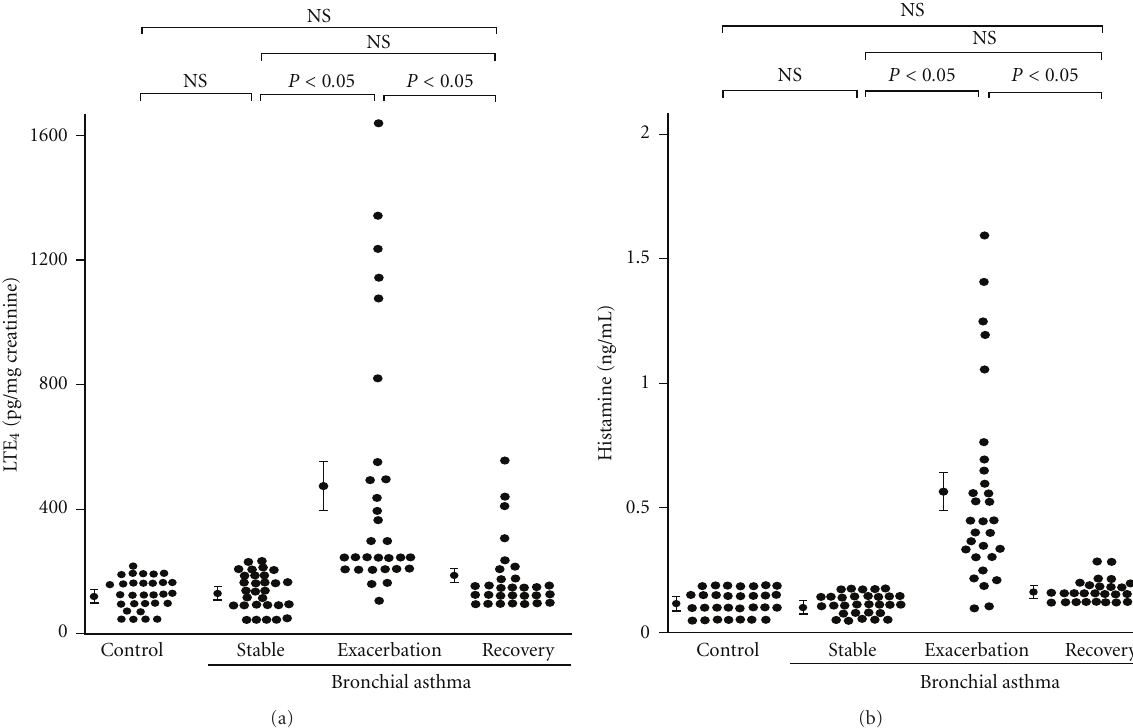
Figure 2: Concentrations of urinary LTE 4 (a) and plasma histamine (b) in control subjects (Control, n = 30) and patients with bronchial asthma ( n = 30) at a stable condition (Stable), during exacerbations (Exacerbation) and after 21 days of treatment with oral glucocorticoids when patients showed evidence of clinical improvement (Recovery). Mean values ± S.E.M. are indicated by closed circles with error bars. NS, not significant. (Cited from